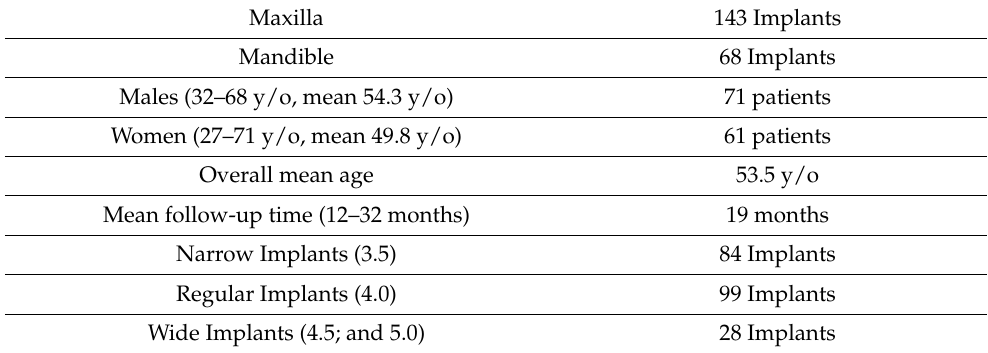
Table 1. Distribution of groups.